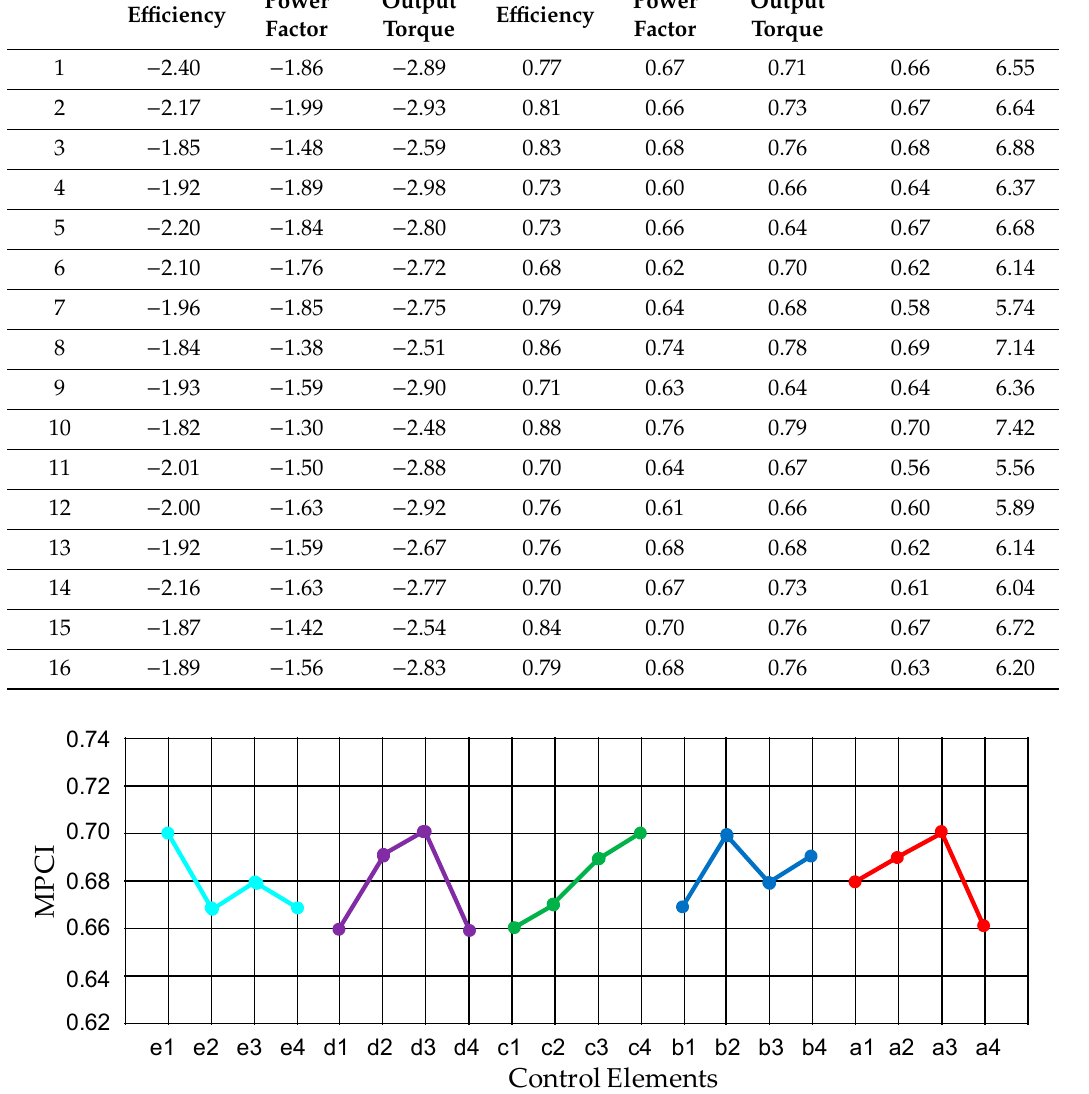
Figure 4. The MPCI values for each element with corresponding levels in the second-phase design.